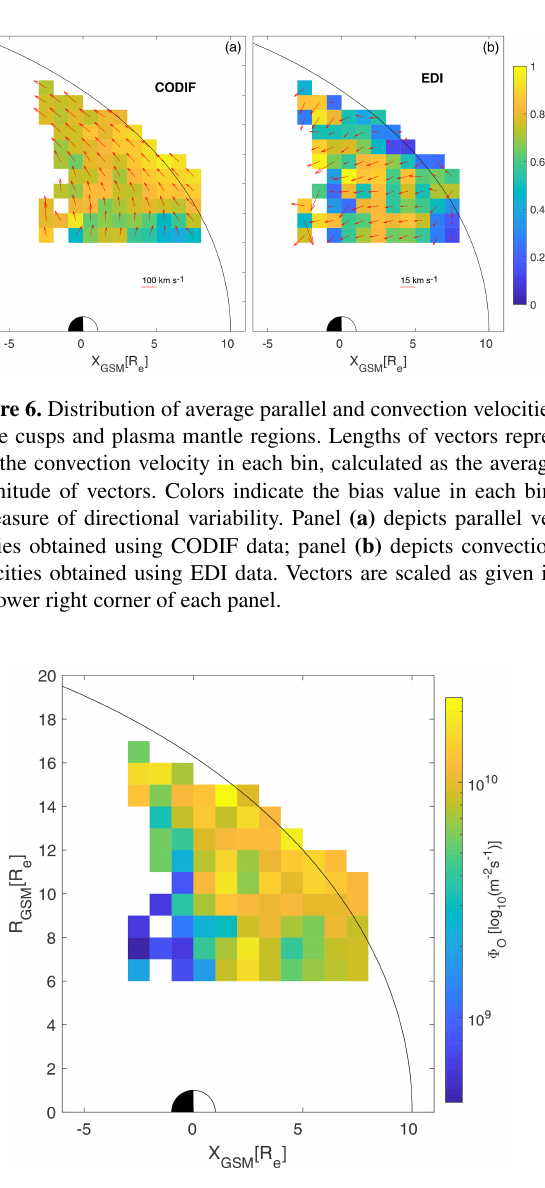
Figure 7. Oxygen flux distribution in each measurement bin. Here we only use bins with both parallel and convection velocity data. The color bar indicates the amount of flux in each bin scaled to the ionospheric level (50000nT).